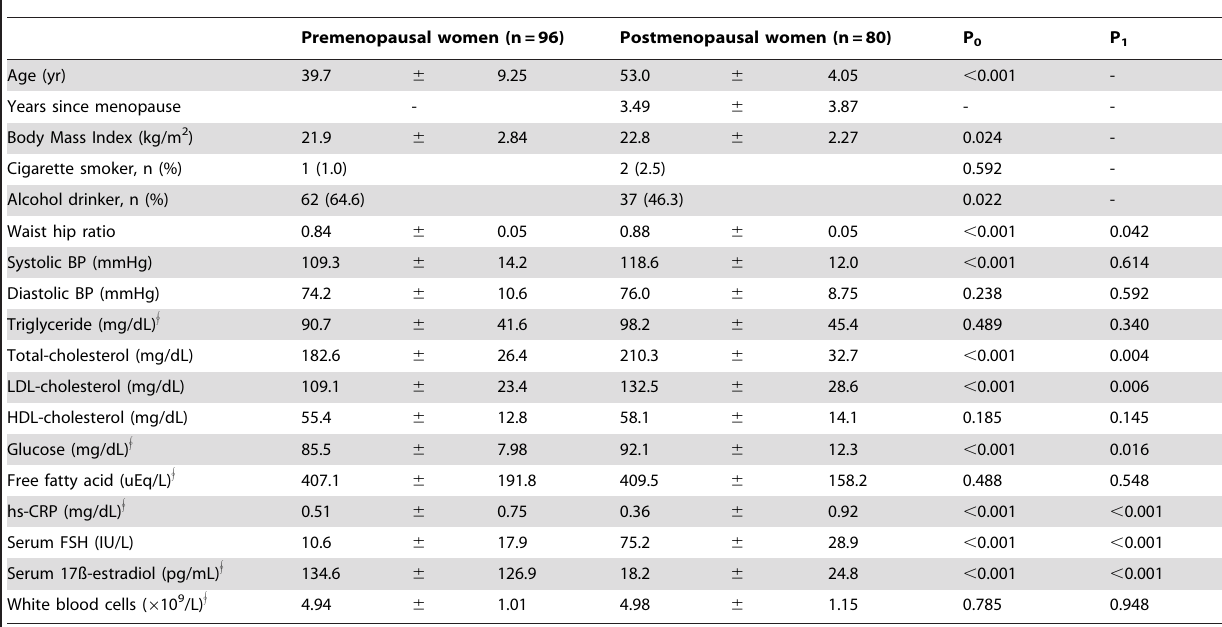
Table 1. Clinical characteristics of the study participants according to menopausal status.